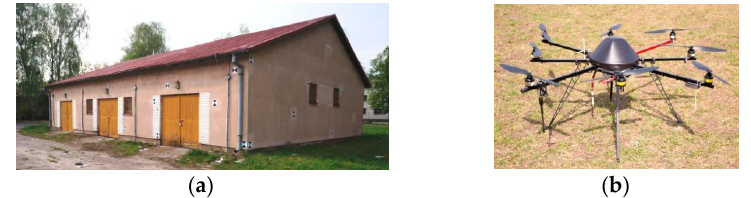
Figure 3. ( a ) Measured architectural structure; ( b ) UAV—octocopter used in studies.